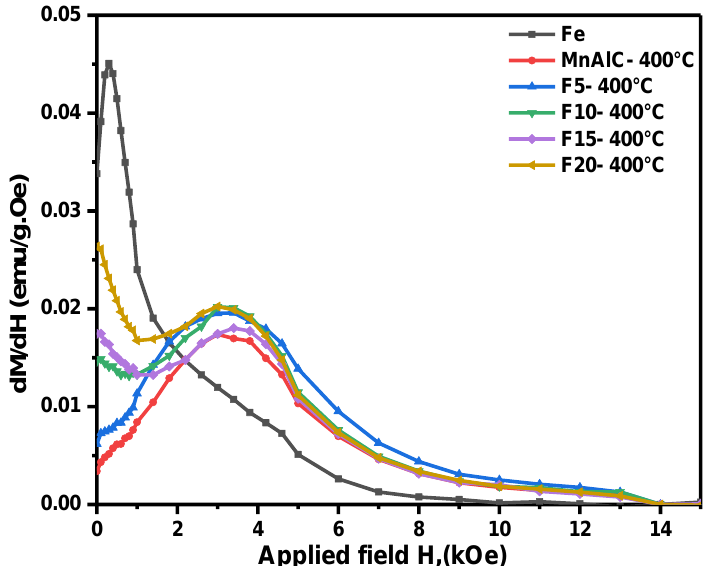
Figure 3. Switching field distribution curves of samples.